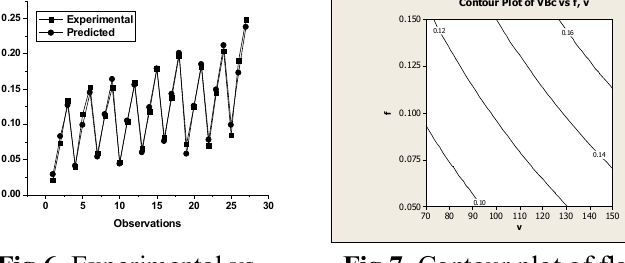
Fig.6. Experimental vs. predicted values of flank wear